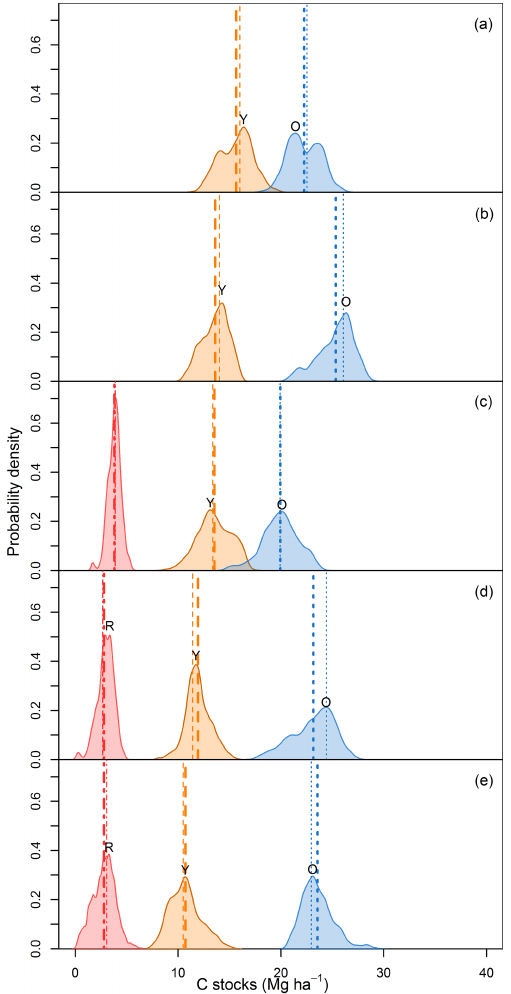
Figure 9. Probability distribution of the initial size of the C pools (Y: Young, O: Old, R: Recalcitrant) in structure I (a) , IV (b) , II (c) , IV (d) , V (e) , with weighting factor = 0.35. On the vertical axis the probability density of the parameter (dimensionless) is depicted and on the horizontal axis the value of the parameter (in Mgha − 1 ) . Vertical lines are representing the mean value (thick lines) and the Venter estimated mode (thin lines) of the Markov